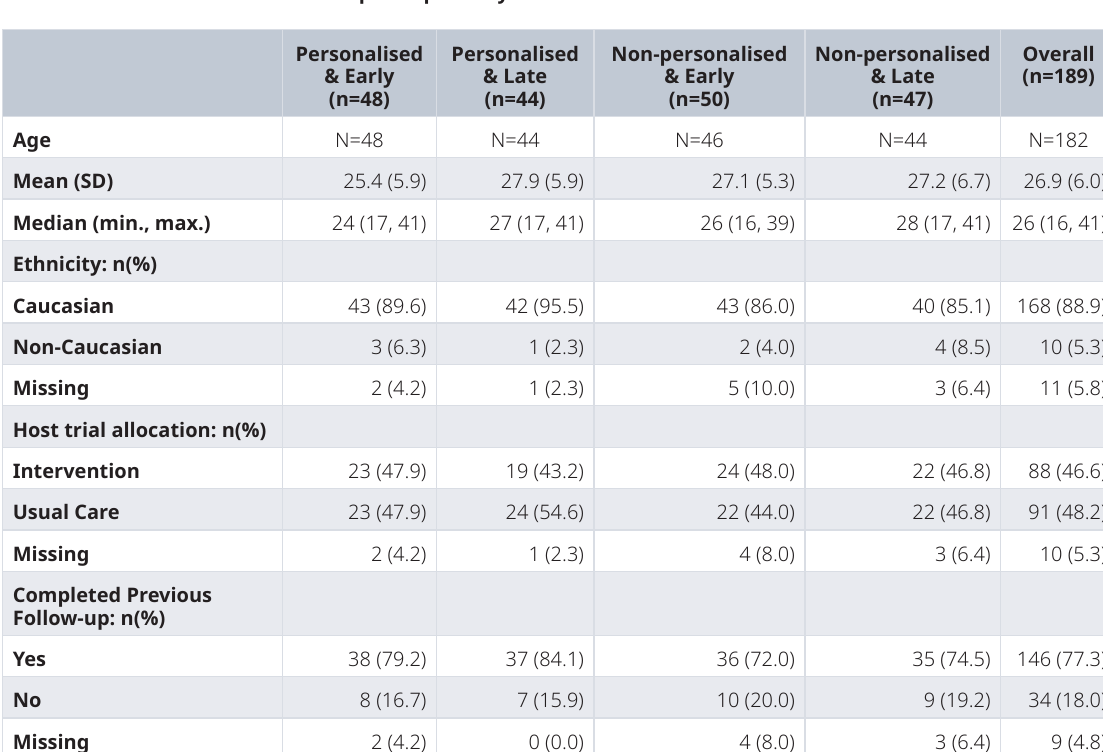
Table 2. Baseline characteristics for participants by SWAT